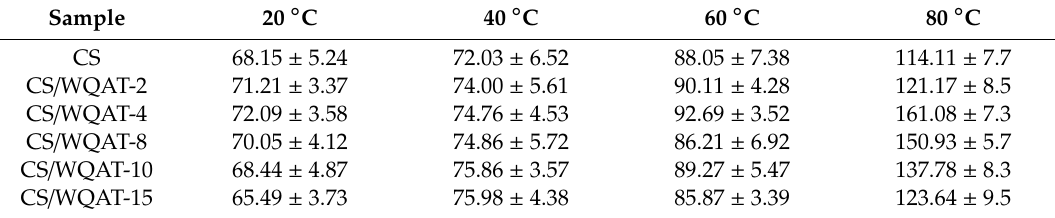
Table 2. Water uptake (%) of the pure CS and CS / WQAT composite membranes.